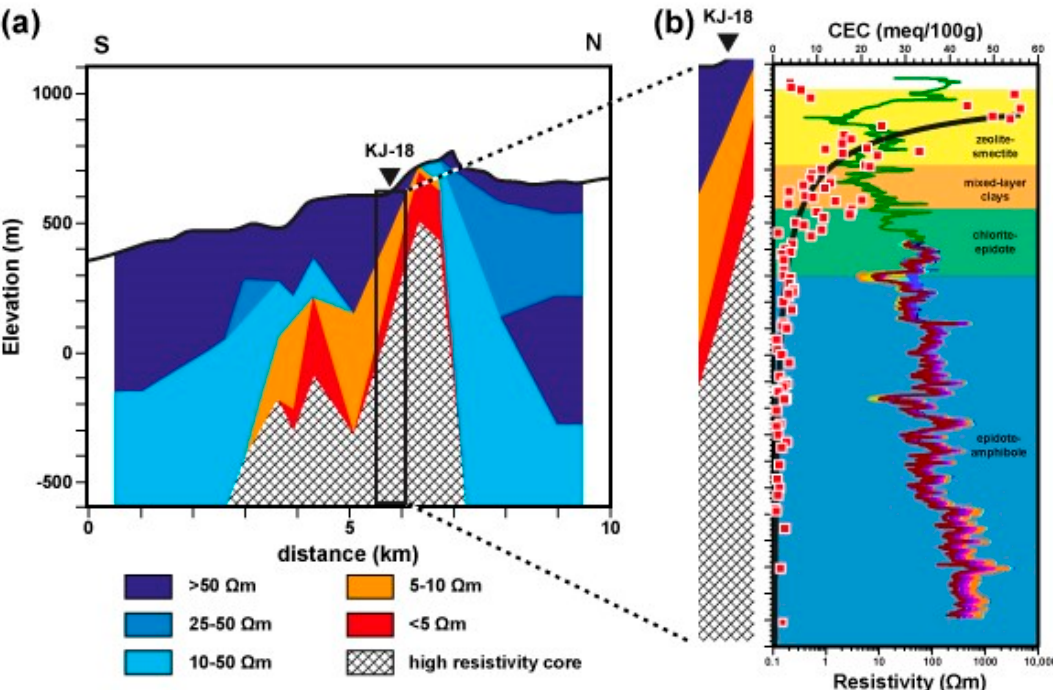
Figure 8. ( a ) South-north lying resistivity cross-section through the Krafla high-temperature geothermal system, north Iceland. The location of the studied well KJ-18 is given. The resistivity structure is based on 1-D inversion of TEM sounding data adapted from Árnason and Magnússon [79]. The more detailed log profile of well KJ-18 is given to the right ( b ) including the resistivity log trend-line of the CEC results.